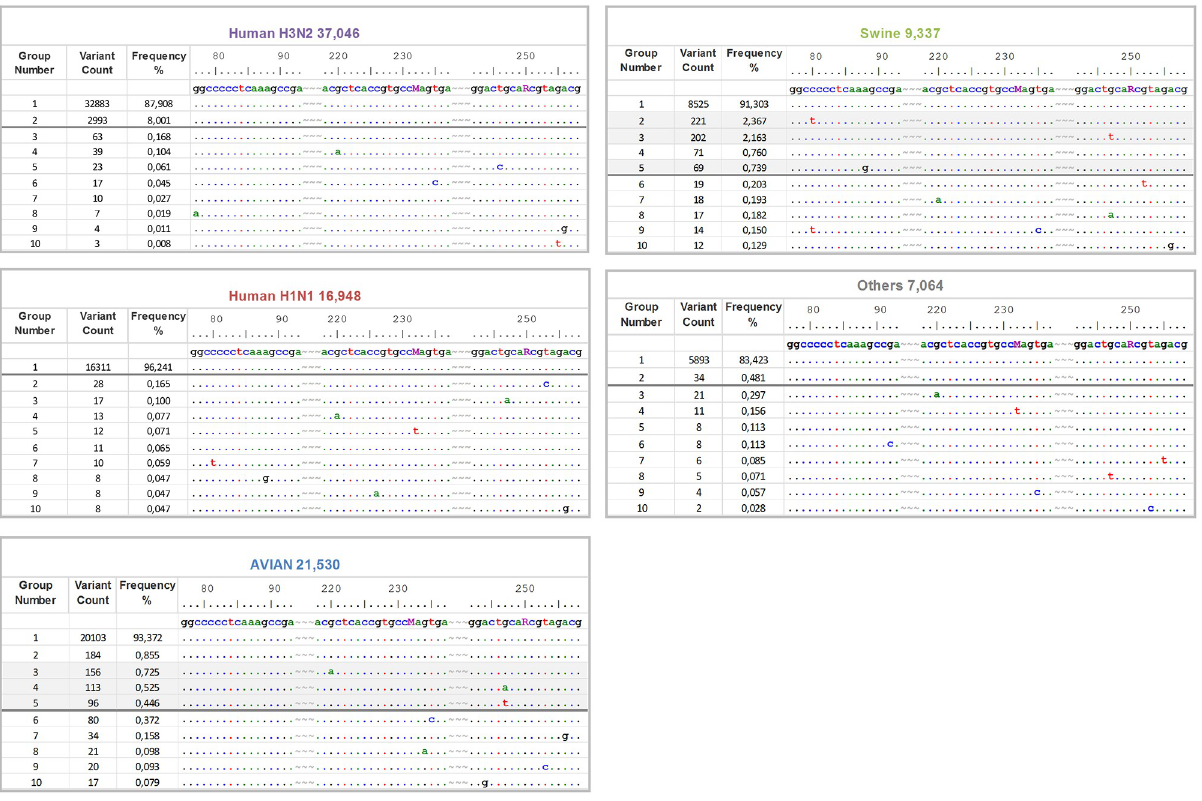
Fig 2. Alignment stratification of the data